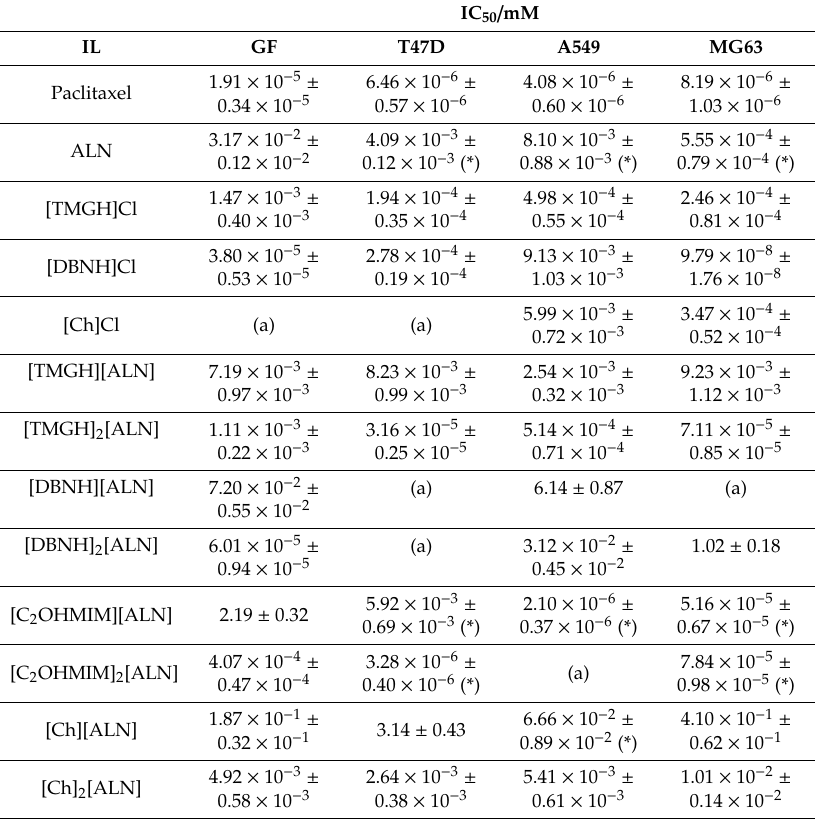
Table 2. Cytotoxicity of the ALN–OSILs on GF cells and T47D, A549 and MG63 cell lines after 24 h.